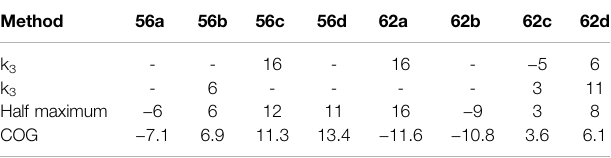
TABLE1| EstimationofLOSvelocitiesoftheeightpro fi lesshownin Figure2D – K